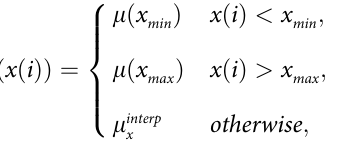
S1 Table. Supplementary tables. Supplementary Tables pertaining to fits, and testing of the passage method are presented